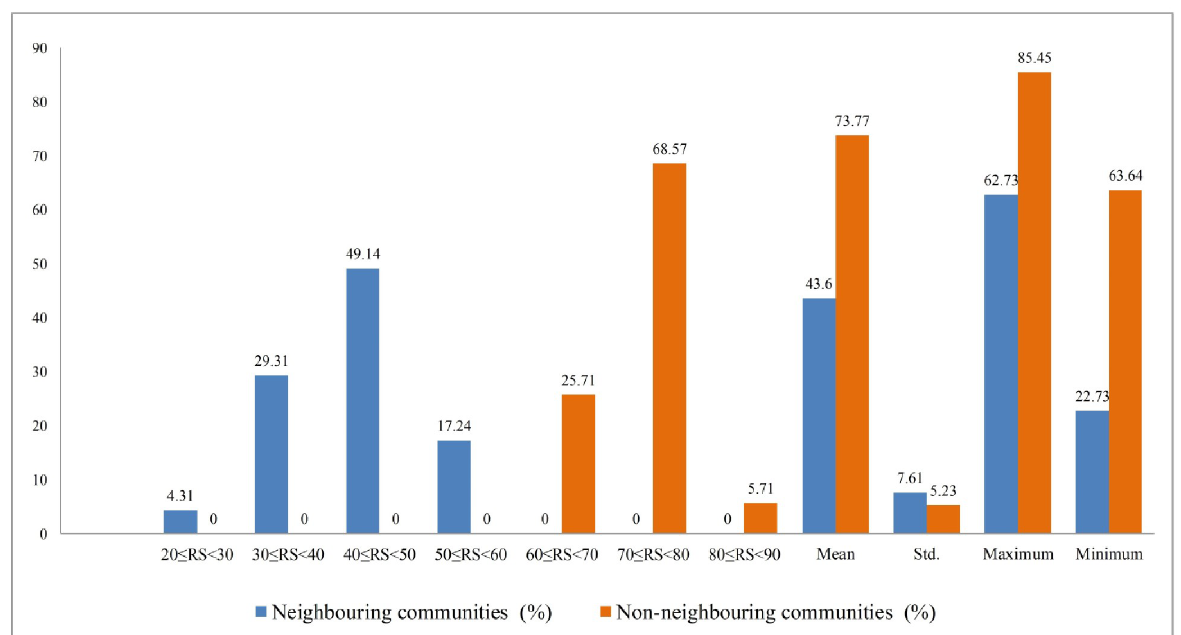
Fig 7. Distribution of overall residential satisfaction. Source: Authors’ compilation,